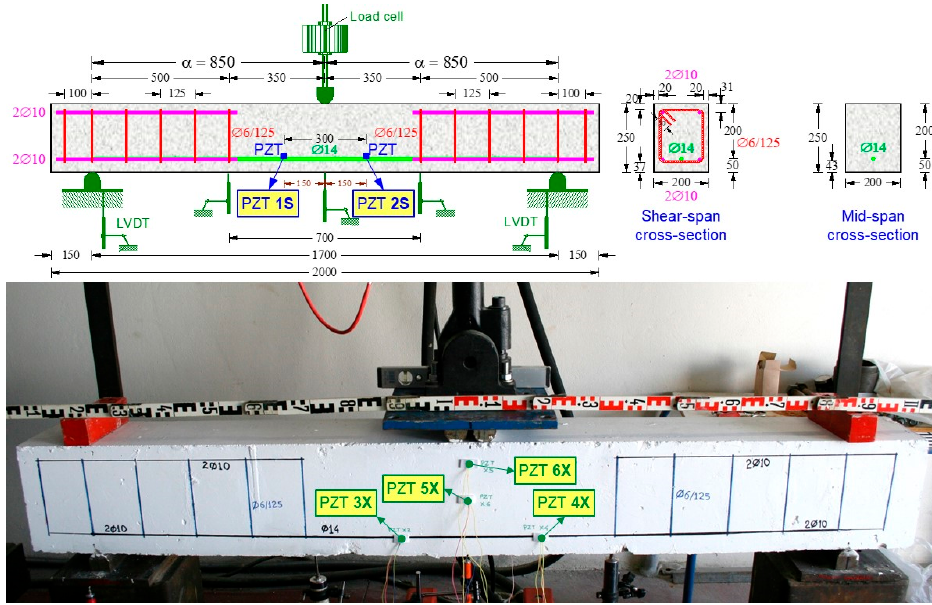
Figure 2. Characteristics of the tested RC FLM beam under monotonic loading. The top longitudinal reinforcement of the FLM beam consisted of two (2) steel bars with a diameter of 10 mm (2Ø10) that extended only in the shear spans of the beam. The bottom longitudinal reinforcement of the FLM beam consisted of two steel bars with a diameter of 10 mm (2Ø10) extending only into the shear spans of the beam and one (1) bar with a diameter of 14 mm (Ø14) extending along its entire length. The beam also had transverse reinforcement in the form of closed stirrups, with a diameter of 6 mm placed only in the shear spans at 125 mm spacing (Ø6/125). The top and bottom longitudinal reinforcement of the FLC beam consisted of two (2) steel bars with a diameter of 12 mm (2Ø12 top and 2Ø12 bottom). The beam also had transverse reinforcement in the form of closed stirrups, with a diameter of 6 mm at equal 200 mm spacing (Ø6/200). The steel yield strength was measured as fy = 595 MPa and 550 MPa, for the Ø14 and the Ø12 longitudinal reinforcing bars of the FLM and FLC beams, respectively. Figures 2 and 3 depict the geometry, the arrangement of the reinforcements and the test rig of the FLM and FLC beams,